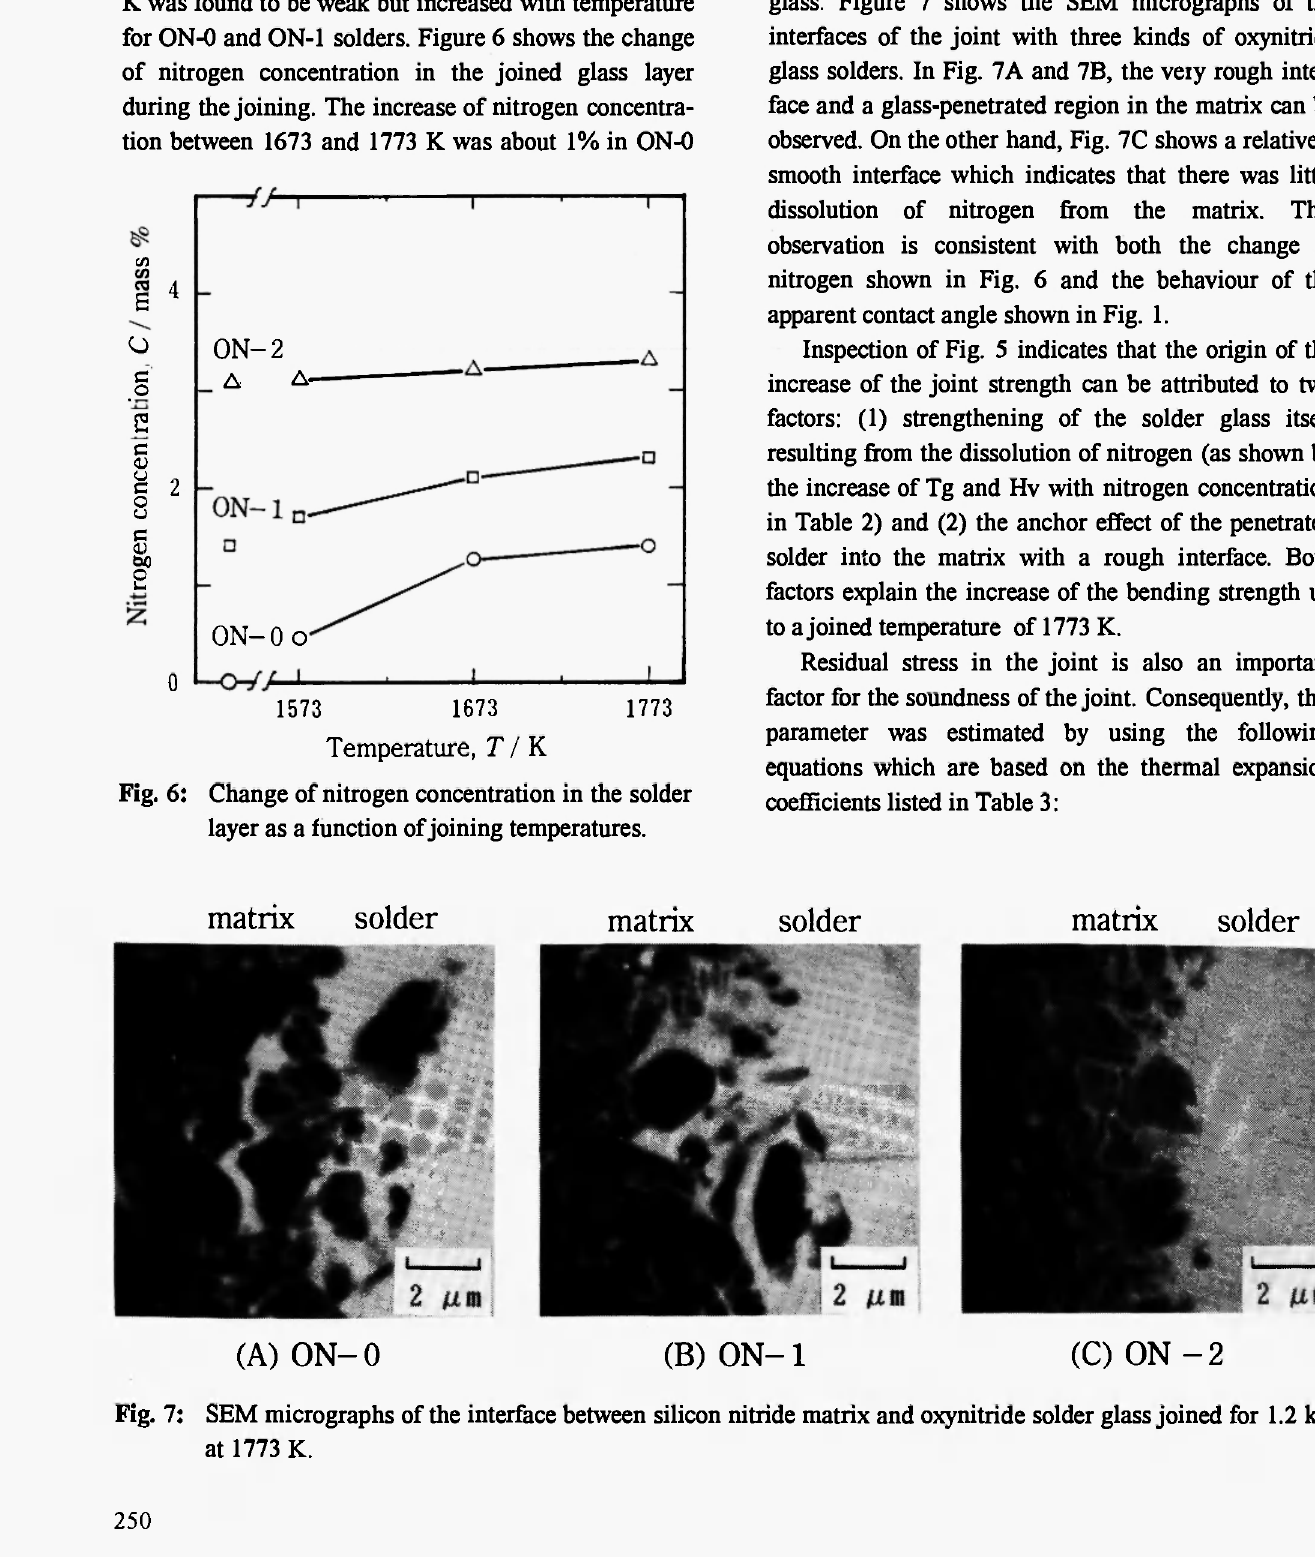
Fig. 7: SEM micrographs of the interface between silicon nitride matrix and oxynitride solder glass joined for 1.2 ks at 1773